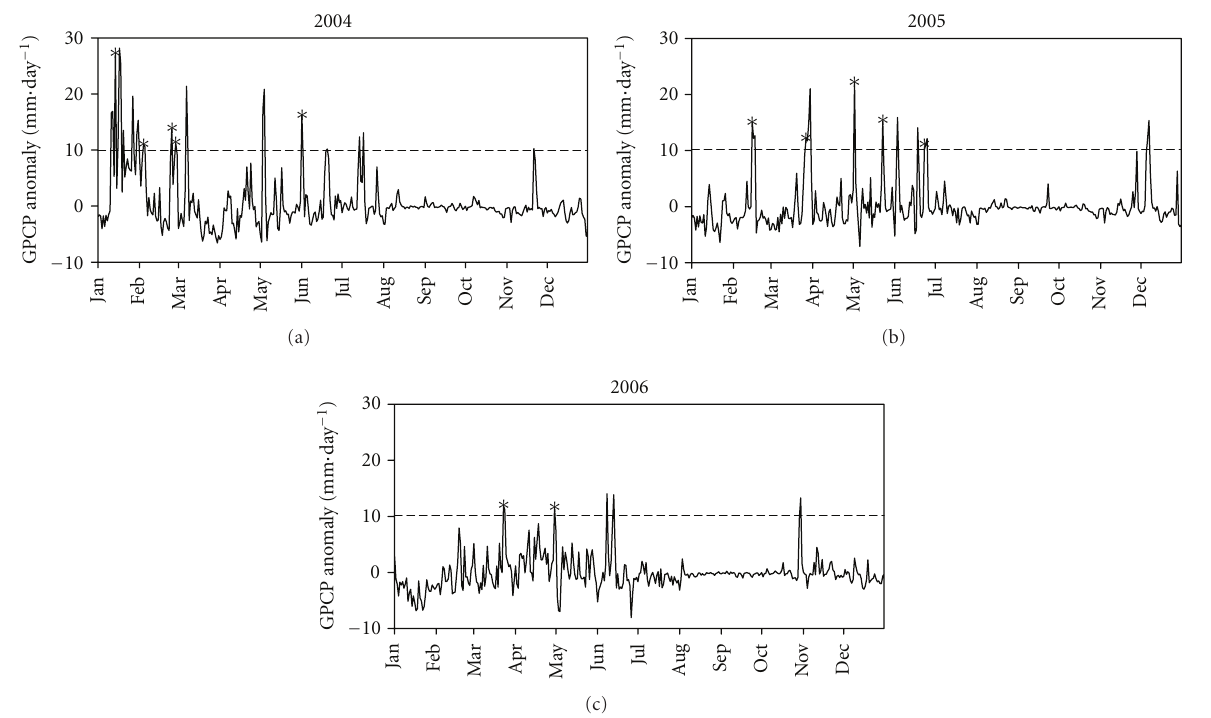
Figure 7: Daily time series of GPCP anomalies (mm · day − 1 ) calculated over ENEB in 2004 (a), 2005 (b), and 2006 (c) from the climatic precipitation, averaged over the same region during the same calendar days for the period 1997–2006. The horizontal dashed line at 10mm · day − 1 represents the limit used to identify the strong precipitation episodes. The twelve selected events are marked by stars (see Table 1 and Figure 8). The tick marks on the x -axis represent the first day of corresponding